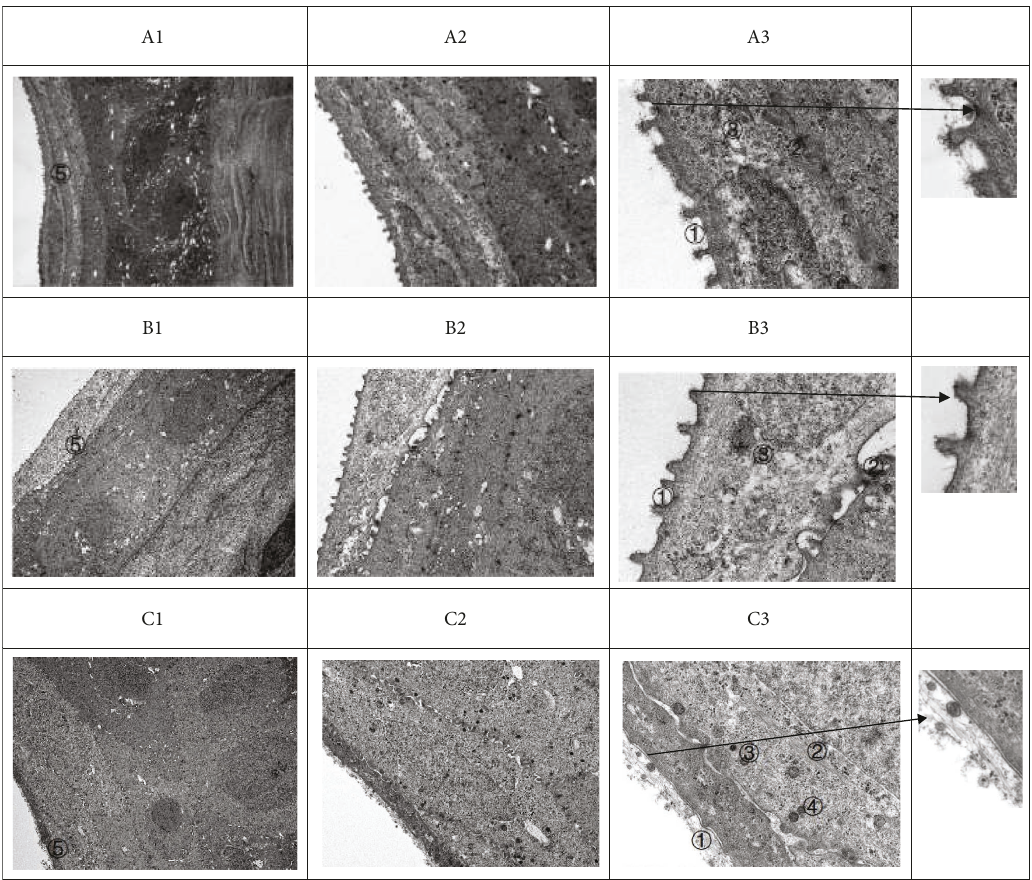
Figure 3: TEM images in each group at 24h after operation. TEM images of group A: 5,000x (A1), 15,000x (A2), and 50,000x (A3); TEM images of group B: 5,000x (B1), 15,000x B1 (B2), and 50,000x (B3); TEM images of group C: 5,000x (C1), 15,000x (C2), and 50,000x (C3). (1) The microvilli in A and B groups are closely and regularly arranged. The microvilli in group C are absent, and the surface epithelial cells are necrotic ( ① ). (2) There are a lot of glycocalyx on the cell membrane of microvilli in A and B groups, but no glycocalyx is seen in in group C ( ① , the enlarged picture is indicated by the arrow). (3) Desmosome junction and hemidesmosome junction can be seen in A and B groups; in group (C), the distribution of desmosome junctions is disordered, the number of desmosomes is reduced, the tension filaments are significantly reduced, and necrotic cells can be seen on one side ( ② ). (4) In group B and C, the mitochondria are swollen, endoplasmic reticulum is expanded, and mitochondrial cristae are damaged ( ③ ); myeloid corpuscles are visible. (5) The number of corneal epithelium layers in group C is more than that in group A and B under transmission electron microscope ( ④ ). (6) The corneal epithelium layers in group C were more than that in group A and B, but the boundary of each stratification is not obvious ( ⑤